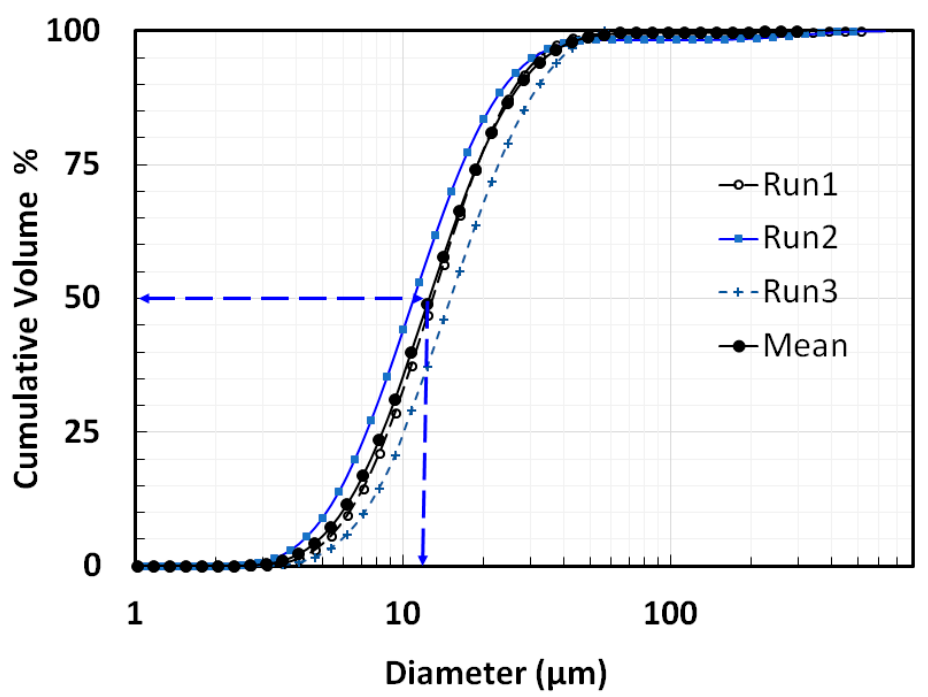
Figure 2. Cumulative particle size distribution of dry sample of sieved nanosilica.